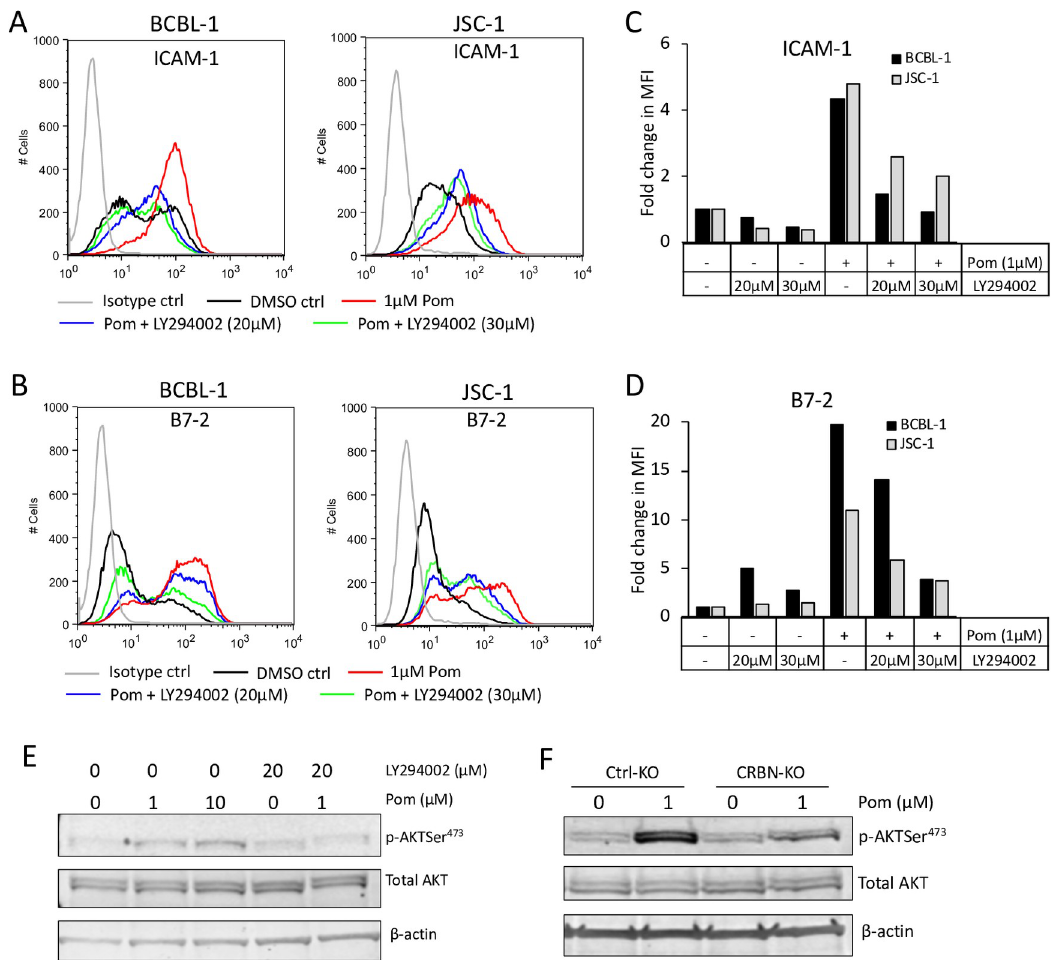
Fig 8. Activation of the PI3K pathway by Pom plays a role in the increases in ICAM-1 and B7-2. PEL cells were pretreated with PI3K inhibitor LY294002 for approximately 1 hour and then treated with Pom for an additional 48 hours. (A and B) Surface expression levels of ICAM-1 (A) and B7-2 (B) measured by flow cytometry using PerCP/Cy5.5-conjugated anti-ICAM-1 or anti-B7- 2 antibodies in BCBL-1 and JSC-1 cells treated with Pom (1 μ M) and/or LY294002 (20 or 30 μ M). (C and D) Fold changes in median fluorescence intensity (MFI) of ICAM-1 (C) and B7-2 (D) upon treatment with Pom and/or LY294002 relative to DMSO-treated control cells. (E) Western blot analyses of cytoplasmic extracts of BCBL-1 cells plated with Pom and/or LY294002 for Phospho and total AKT. (F) Western blot analysis of whole cell lysates of Ctrl-KO or CRBN-KO BCBL-1 cells treated for 48 hours with DMSO control or 1 μ M Pom. β -actin is used as a loading control. These experiments were performed 3 times and the results from one representative experiment are